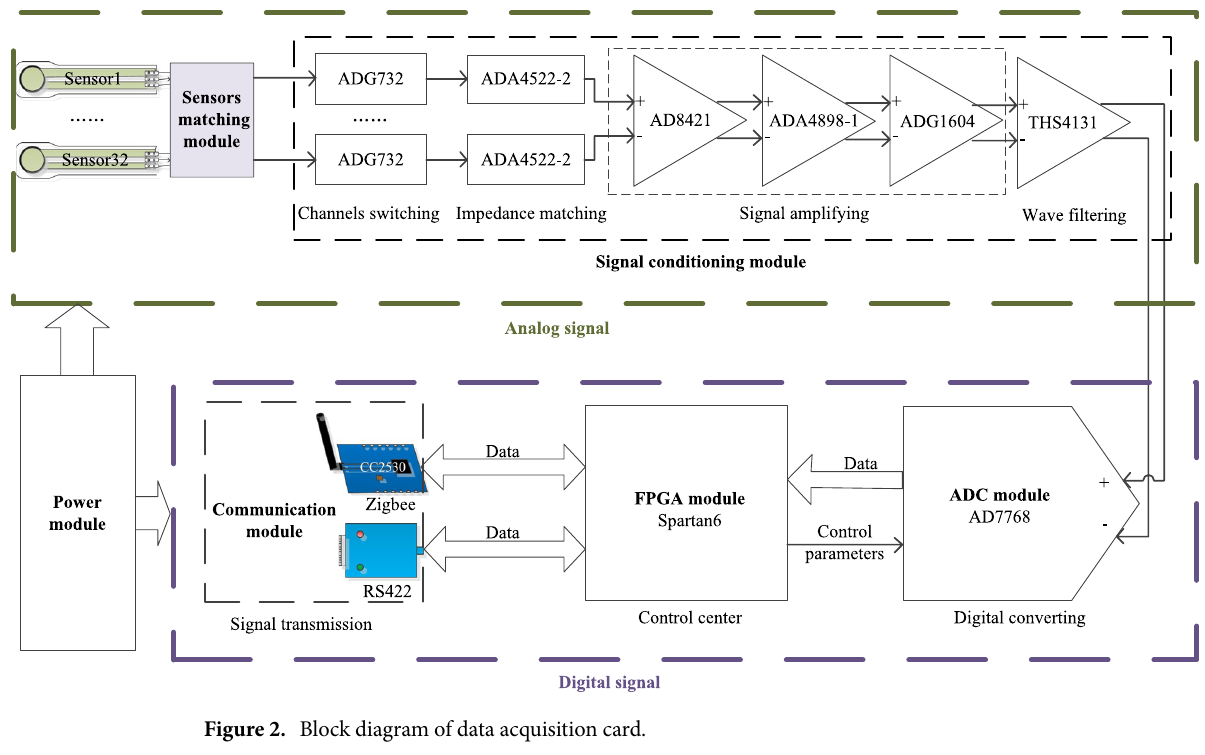
Figure 2. Block diagram of data acquisition card.